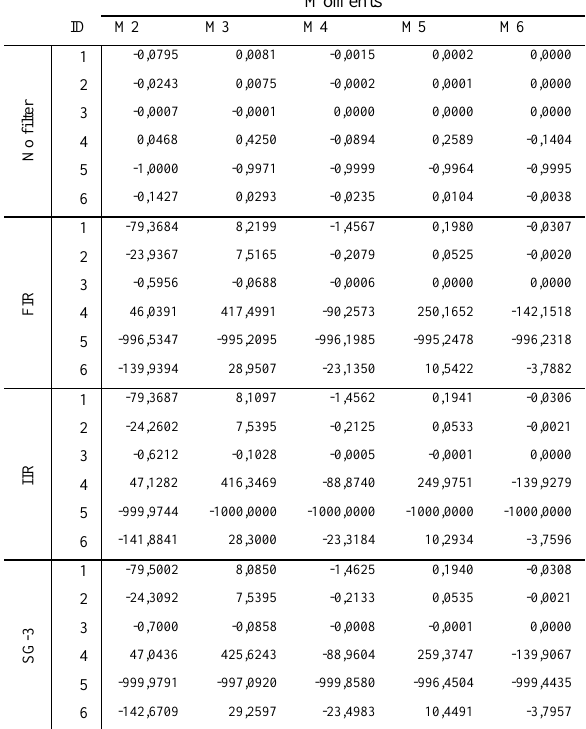
Table 4: Difference in values for the 2 nd up to 6 th moment between the actual trajectory and the Kinect trajectory (no filter), including the corrected trajectories using the signal filters. For each moment the values were normalized and multiplied by 1000 for illustration